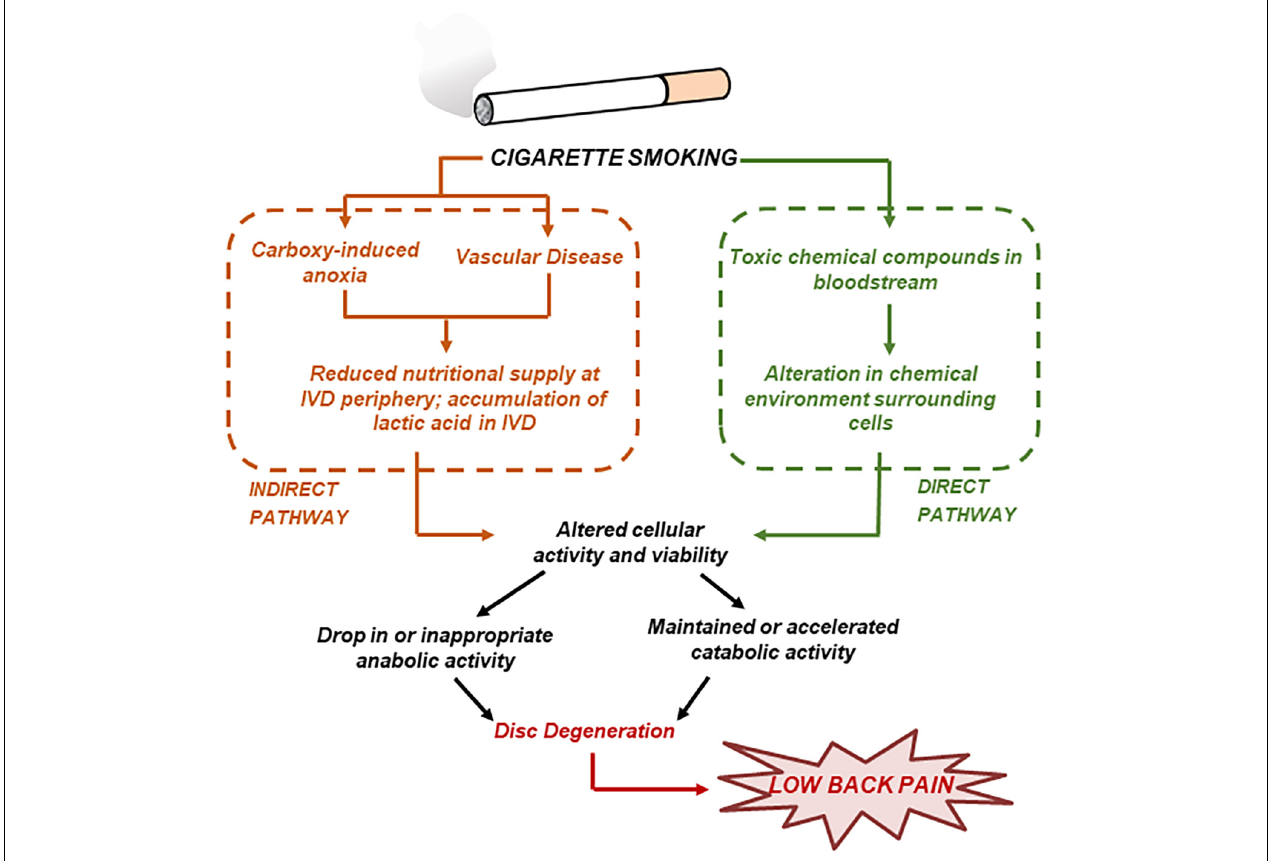
FIGURE 3 | Cigarette smoking may result in disc degeneration by both direct and indirect pathways. Adapted from Jackson et al.